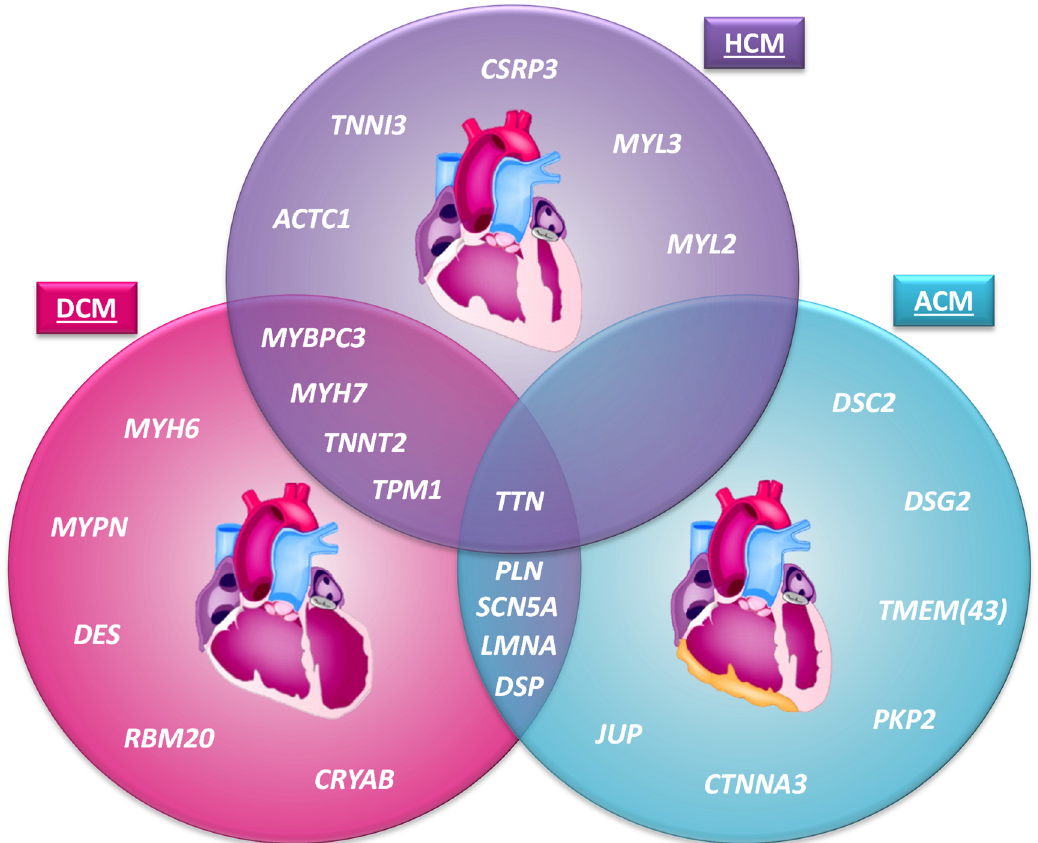
Figure 1. The most common genetic cardiomyopathies and a selection of the most frequently implicated genes. The hearts used in this figure are adapted from McCauley and Wehrens (2009) [23], licensed under a Creative Commons Attribution Non-Commercial Share Alike 3.0 Unported License (https://creativecommons.org/licenses/by-nc-sa/3.0/legalcode, accessed on 14 March 2021). ACM = arrhythmogenic cardiomyopathy; DCM = dilated cardiomyopathy; HCM = hypertrophic